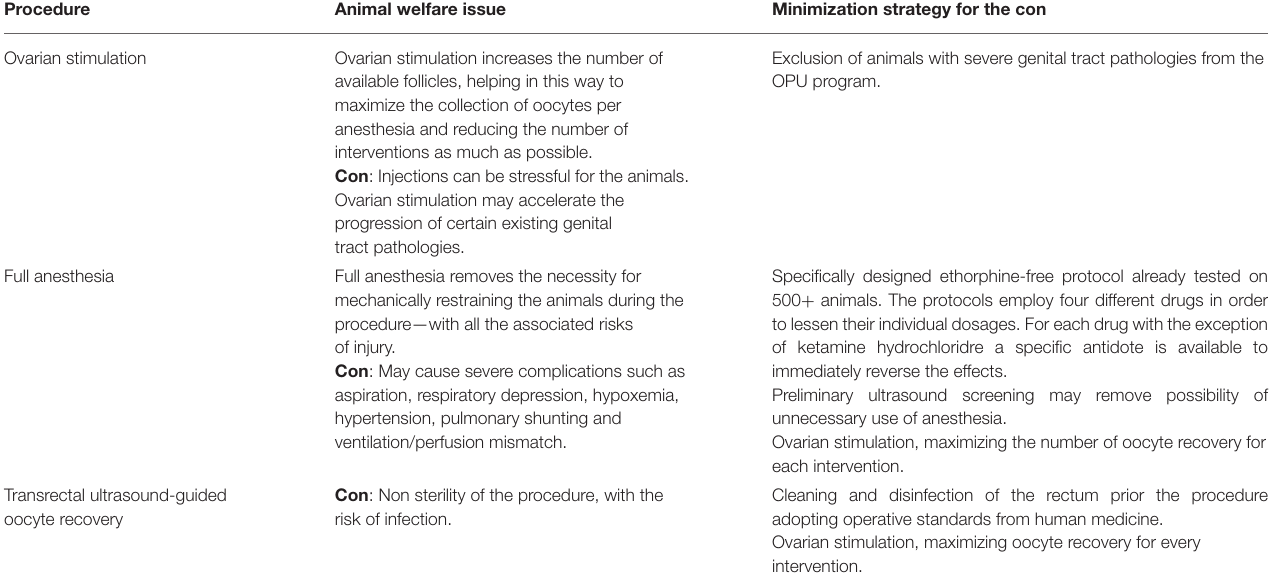
TABLE 6 | Welfare issues and minimization strategies.